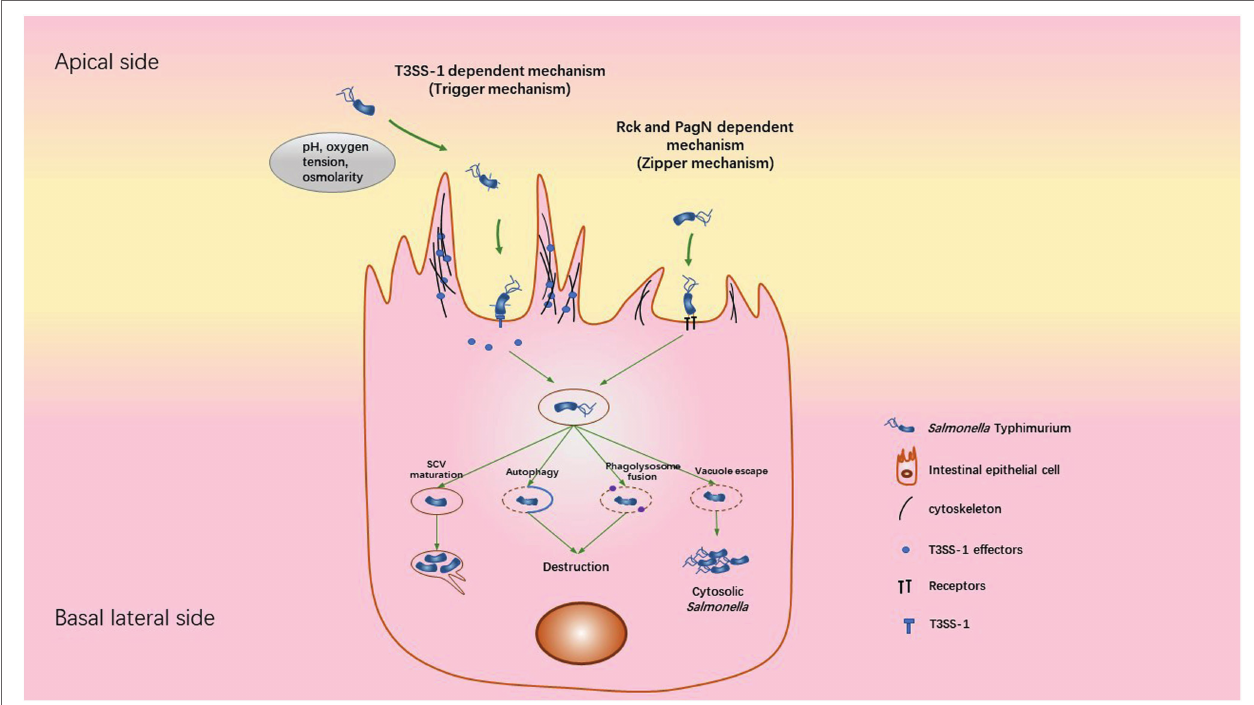
FIGURE 2 | Mechanisms used by STm to invade, survive and replicate inside cell. STm can invade cells using two different ways: the trigger and zipper mechanism. The Trigger mechanism requires the T3SS-1 to directly translocate bacterial effectors into host cells, leading to a massive reorganization of the actin cytoskeleton. Following the invasion, STm is contained in the SCV, where it can replicate. This bacterial replication is accompanied by Sif formation from the SCV, allowing the transport of nutrients to SCV. When the SCV is damaged, the fusion of SCV-Lysosome or the autophagy response could destroy the bacteria. A subset of bacteria is able to escape the SCV into the cytosol. The cytosolic niche is associated with Salmonella hyper-replication. The zipper mechanism requires the direct interaction of Salmonella outer membrane proteins (Rck or PagN) with a specific receptor (EGFR for Rck or proteoglycan/ β 1 integrin for PagN) on the membrane surface of the target cell, leading to actin polymerization, weak membrane rearrangement and internalization of the bacteria inside a vacuole. However, the intracellular behavior of Salmonella following this invasion process remains